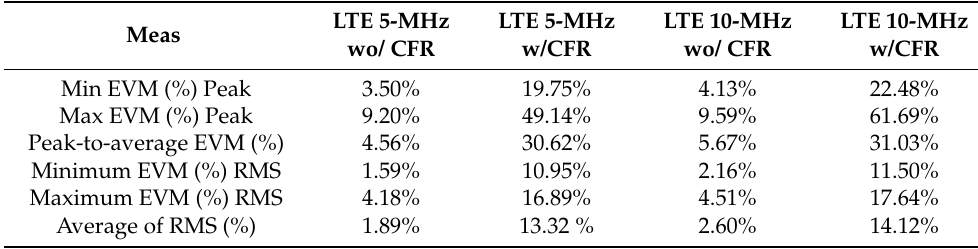
Table 1. EVM performance for LTE 5-MHz and LTE